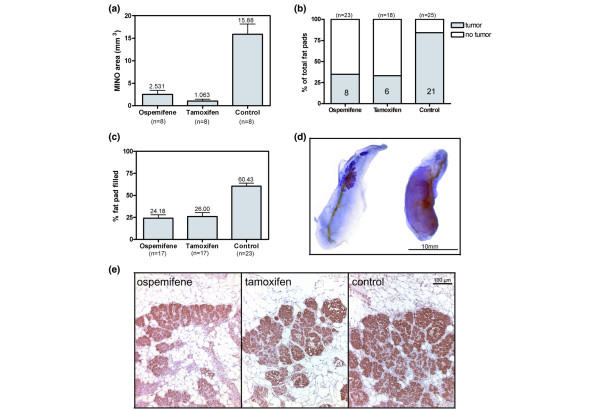
Effect of the selective estrogen receptor modulator (SERM) treatments. (a) Relative amount of mammary intraepithelial neoplasia outgrowth (MIN-O) tissue at 3 weeks after transplantation. The amount of MIN-O tissue in the fat pads of mice treated with ospemifene or tamoxifen was significantly less than that of untreated mice (P < 0.0001). (b) Tumor incidence of the MIN-O-transplanted fat pads at 10 weeks after transplantation. The actual number of tumor-bearing fat pads is shown within each bar. Tumor incidence in SERM-treated fat pads was significantly lower than in the untreated fat pads (P = 0.0009 for ospemifene and P = 0.0012 for tamoxifen). (c) MIN-O size at 10 weeks after transplantation. The ospemifene-treated and tamoxifen-treated MIN-Os were significantly smaller than the untreated MIN-Os 10 weeks after treatment (P < 0.0001). (d) Whole mounts of ospemifene-treated (left) and untreated (right) mammary fat pads at 10 weeks after transplantation. The untreated fat pad has a larger MIN-O area (dark blue). (e) Polyomavirus middle T (PyV-mT) expression in the MIN-Os was detected by immunohistochemistry with anti-PyV-mT antibody. Strong cytoplasmic expression of PyV-mT remained after the SERM treatment.